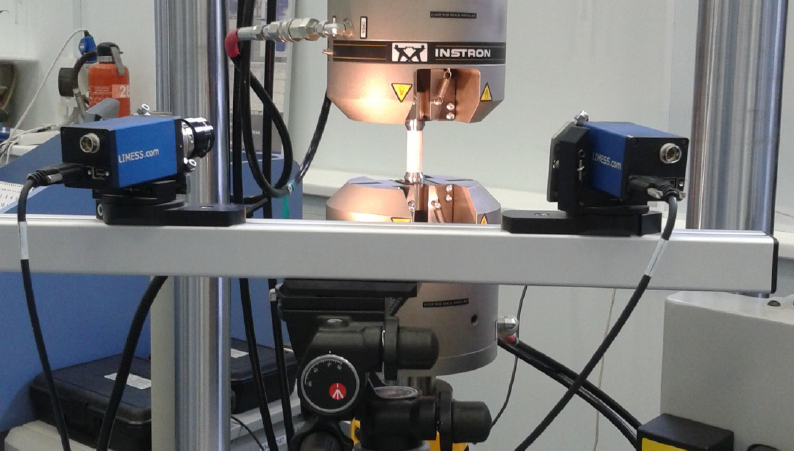
Figure 1: The non-contact three-dimensional digital optical system Vic-3D.